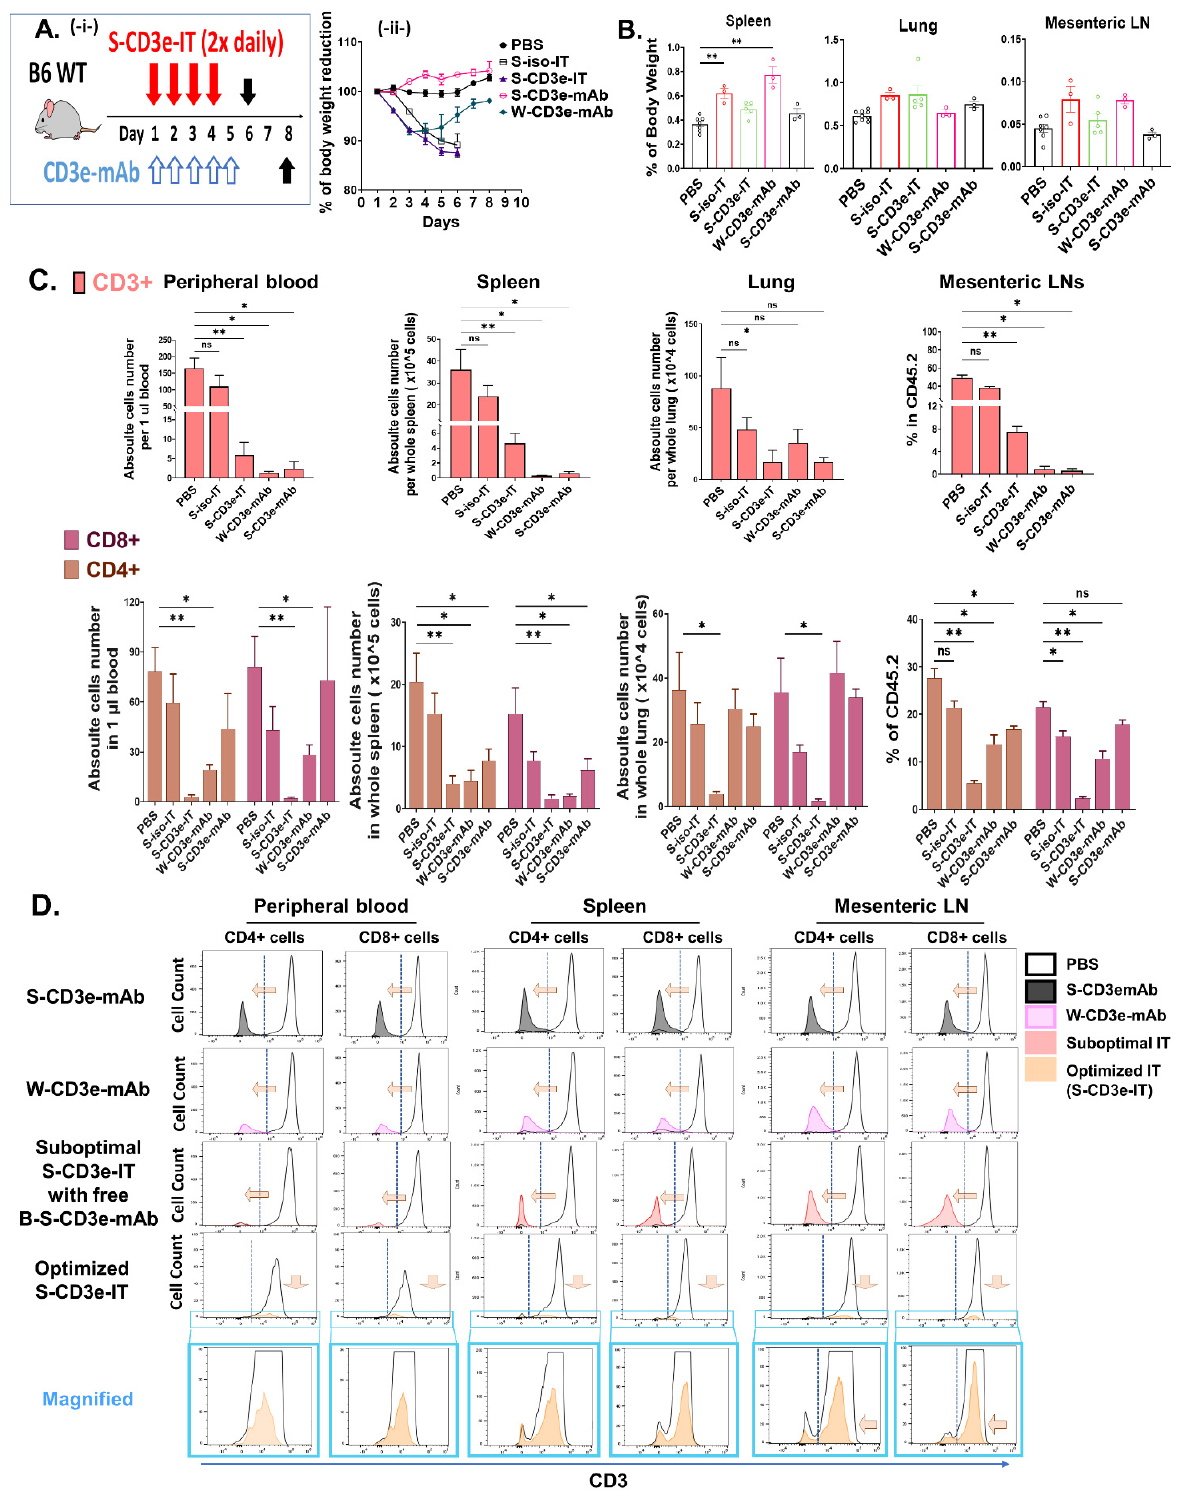
Figure 2. Distinct modes of action by non-mitogenic 145-2C11 and S-CD3e-IT in mice. ( A ) Treatment strategy is shown on the left ( -i- ) and a chart for the body weight changes over time is shown on the right ( -ii- ). ( B ) Organ weights are shown as % of body weight. ( C ) CD3+ cells ( upper panel ) and CD4+ and CD8+ lymphocytes ( lower panel ) are shown for the peripheral blood (absolute number per 1 μ L blood), spleen (absolute number per whole spleen), lung (absolute number per whole lung), and mesenteric lymph nodes (LNs; % in CD45.2+ leukocytes). Cell numbers were determined based